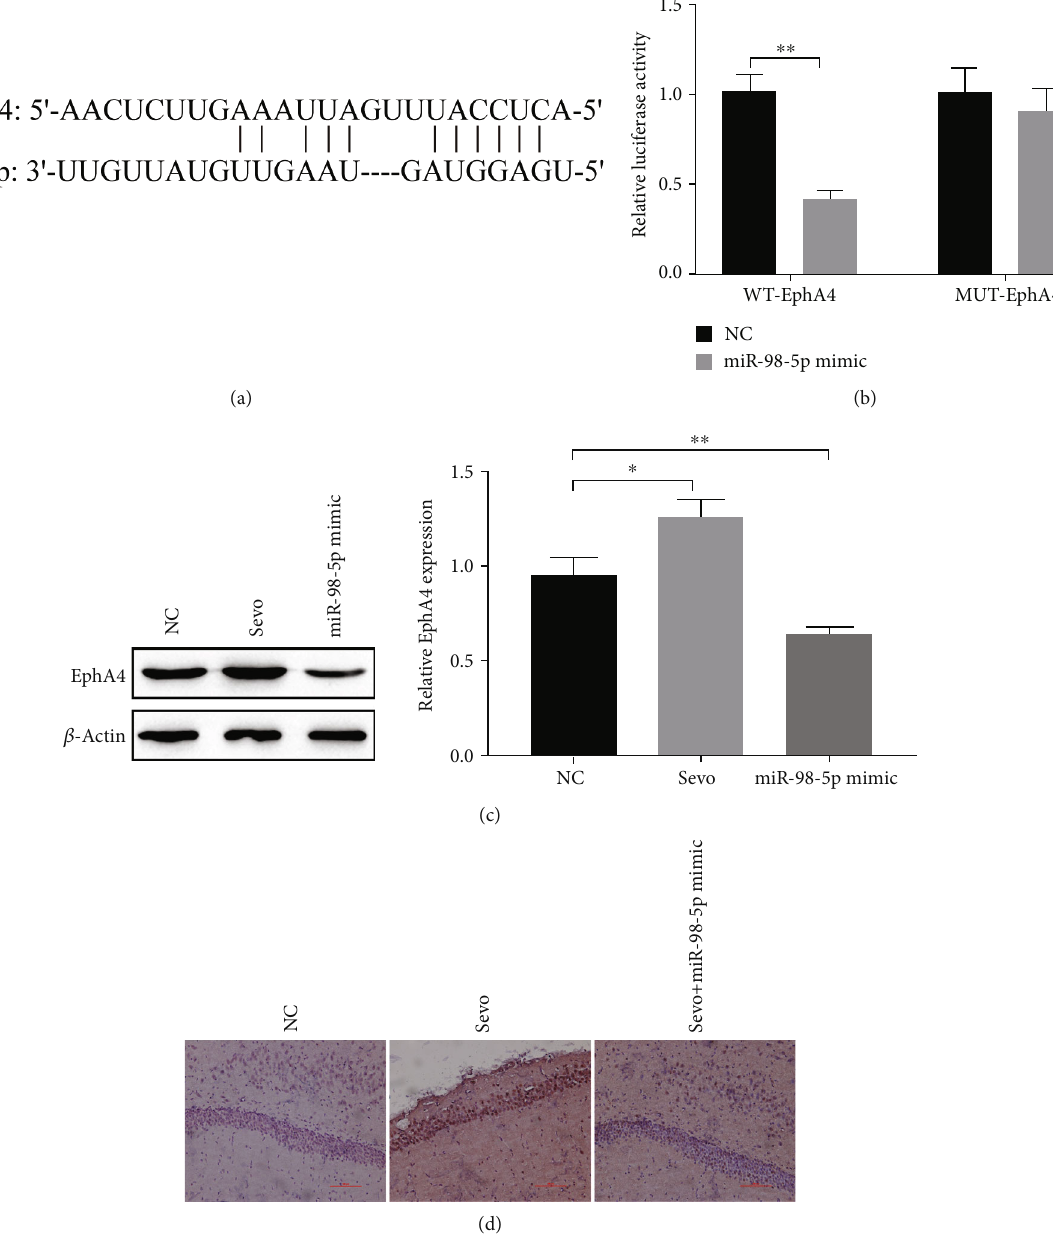
Figure 5: miR-98-5p targets EphA4. (a) Starbase predicts that EphA4 is the target of miR-98-5p. (b) Dual-luciferase reporter gene acknowledged the targeting relationship. (c) Western blot detects EphA4 expression in neurons. (d) Immunohistochemical detection of EphA4 expression in rat hippocampus. ∗ P < 0 : 05 , ∗∗ P < 0 : 01